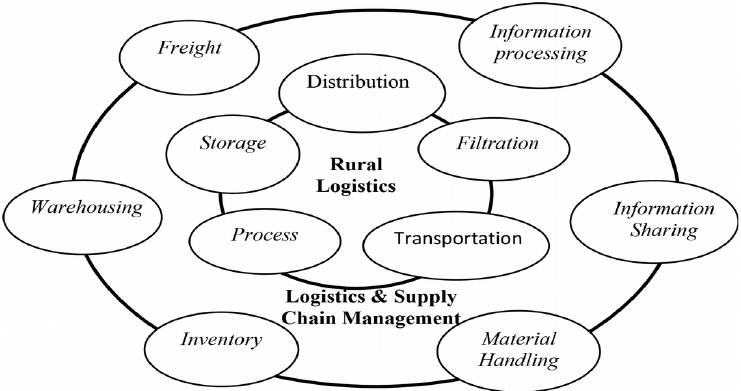
Figure 4. The management functions of the rural logistics